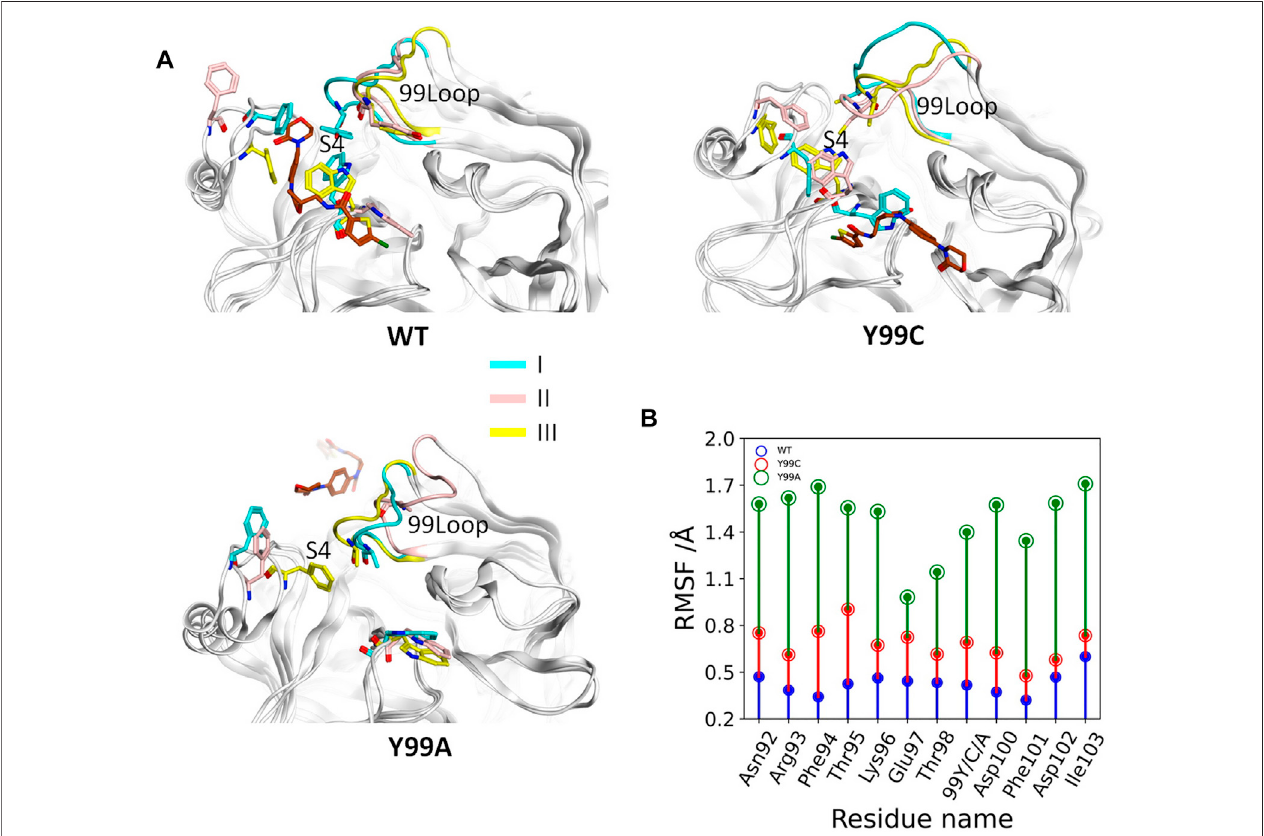
FIGURE3| Comparisonofthe99-loop fl uctuationinWT,Y99C,andY99AmutantofcoagulationfactorX. (A) Representativeconformationsofthetopclusterfrom the three trajectories in three systems, with RIV (brown), the backbone of 99-loop, and the residues 99, Phe174, and Trp215 shown and colored. (B) Time evolution of average RMSF of 99-loop residues in WT (blue), Y99C (red), and Y99A (green) mutant of FX.